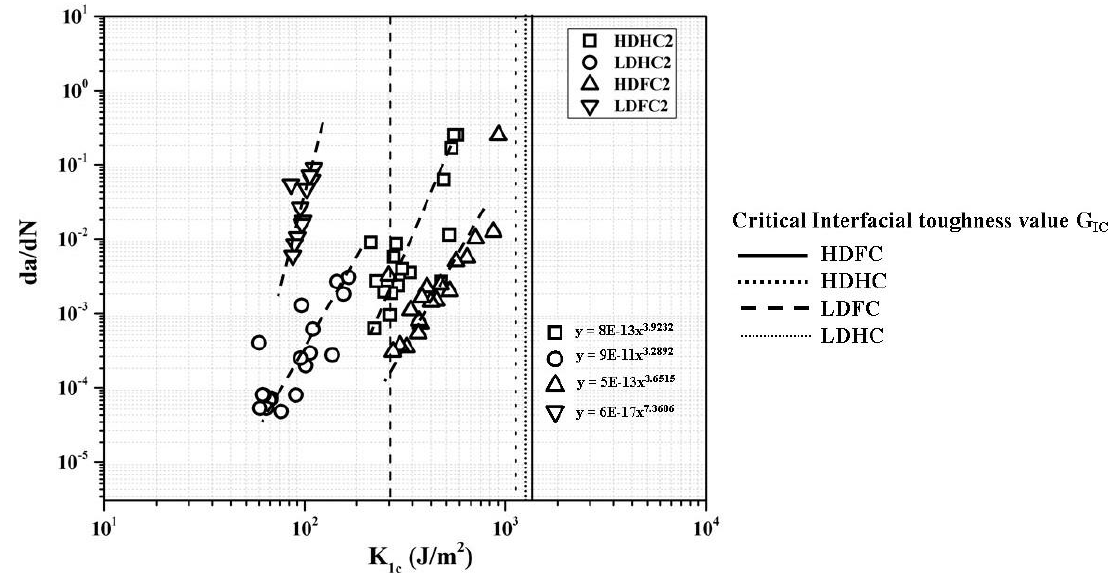
Figure 18. Paris law region II plot for 4 different SCB sandwich specimen configurations.